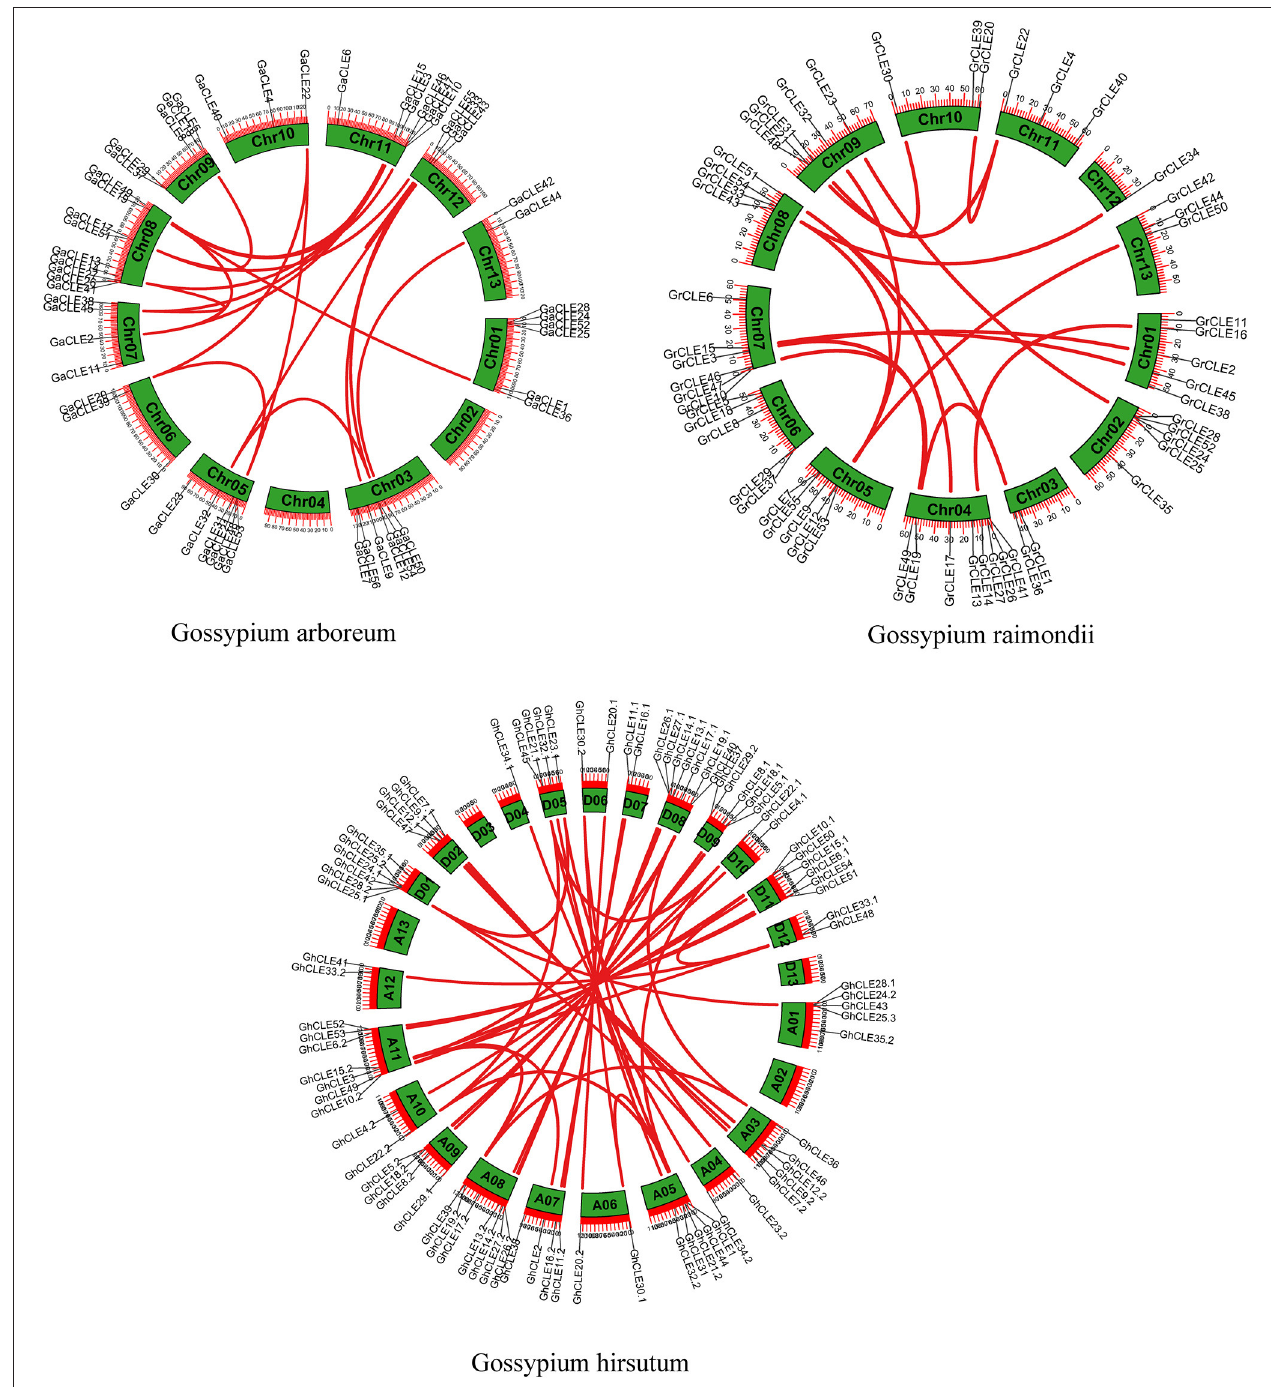
FIGURE 2 | Distribution of CLE gene pairs on chromosomes in intra-genomics of G.arboreum , G. raimondii, and G. hirsutum . The green boxes represent chromosomes and the red lines represent CLE homologous pairs.